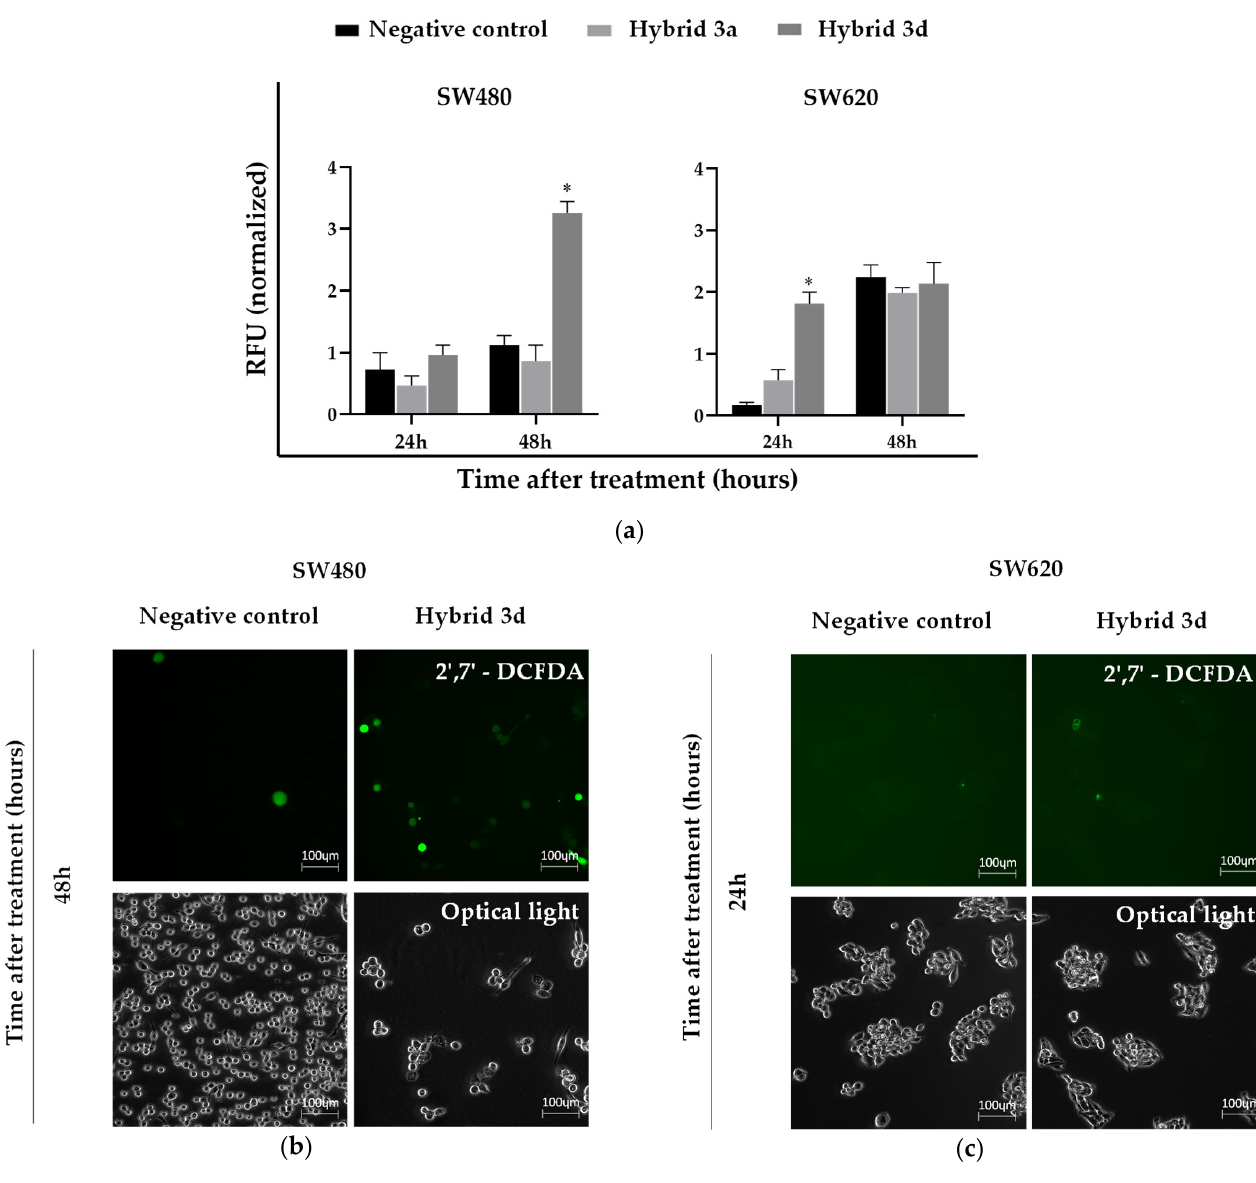
Figure 3. Intracellular ROS production: ( a ) quantification of ROS in SW480 and SW620 cell lines after 24 and 48 h of treatment with hybrids 3a and 3d ; ( b ) representative images of the SW480 cell line at 48 h post-treatment with hybrid 3d and ( c ) representative images of the SW620 cell line at 24 h post-treatment with hybrid 3d . Magnification: 20×. Data are presented as the mean ± SE of at least three replicates (* p < 0.05 vs. negative control). RFU: Relative Fluorescence Units.